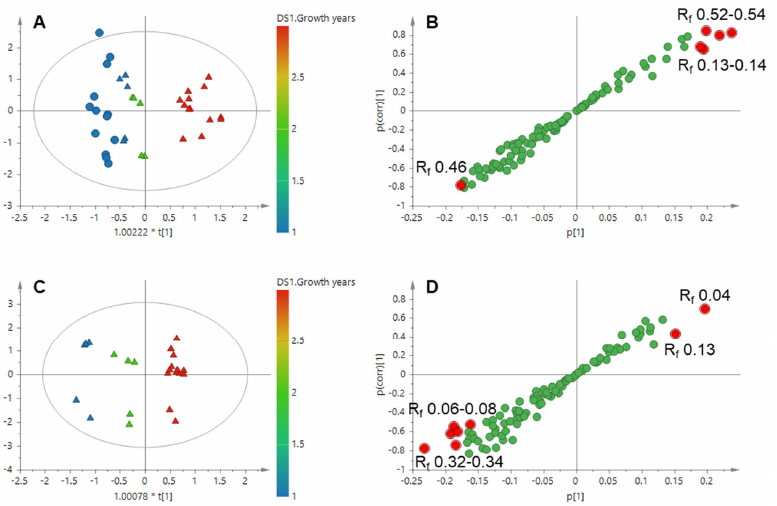
Figure 4. OPLS based on the HPTLC profiles of CMD and ZMD samples with different growth years. ( A ) OPLS score plot of CMD and ZMD (R 2 X = 0.601, R 2 Y = 0.910, Q 2 = 0.859), ( B ) OPLS S ‐ plot of CMD and ZMD, ( C ) OPLS score plot of ZMD with different growth years (R 2 X = 0.849, R 2 Y = 0.978, Q 2 = 0.897), ( D ) OPLS S ‐ plot of ZMD with different growth years. The variables with VIP > 1.5 in the S ‐ plots were highlighted with red filled circles.